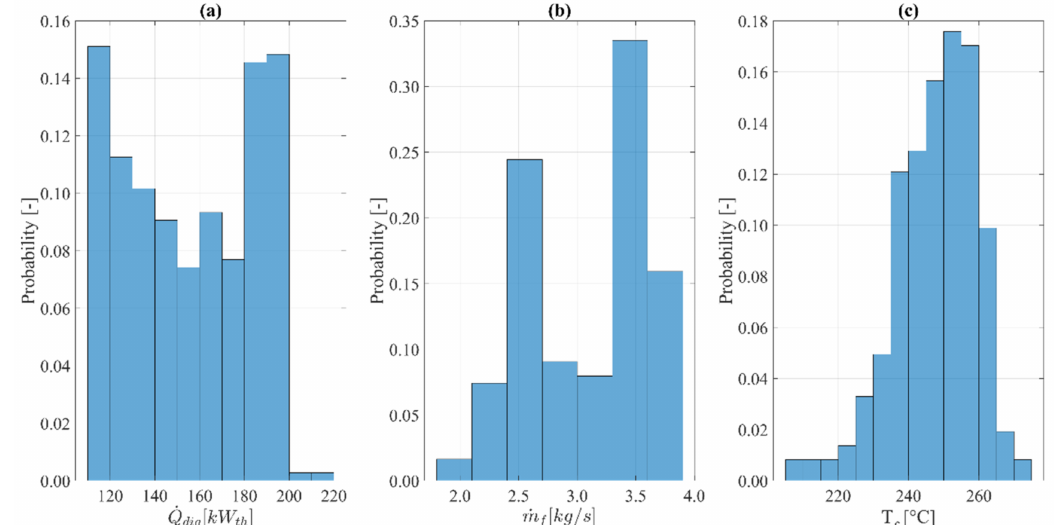
. m f in kg/s. ( c ) Micro gas turbine exhaust temperature T f in ◦ C. Data